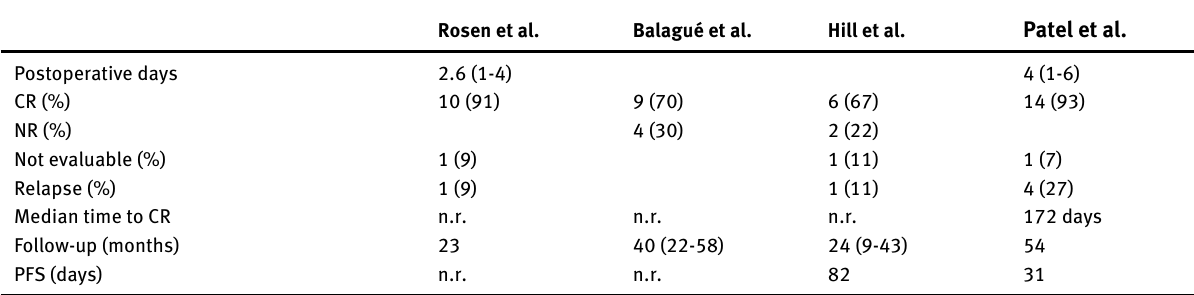
Table 5: Response after splenectomy